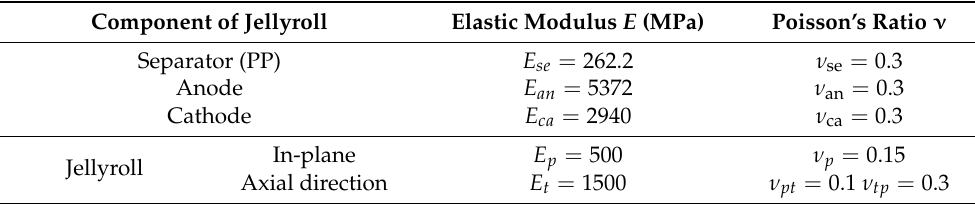
Table 1. Material properties of components of jellyroll. Reprinted with permission from Ref. [19]. 2016, Elsevier